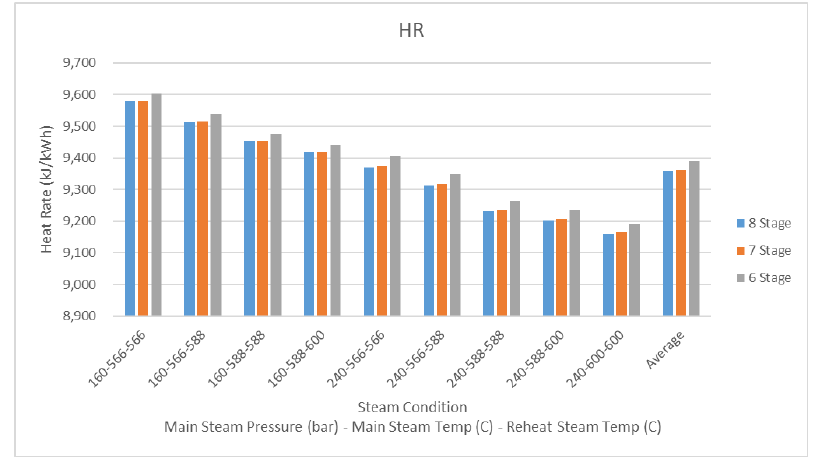
Figure 4. Heat rate average according to the steam condition and the heater